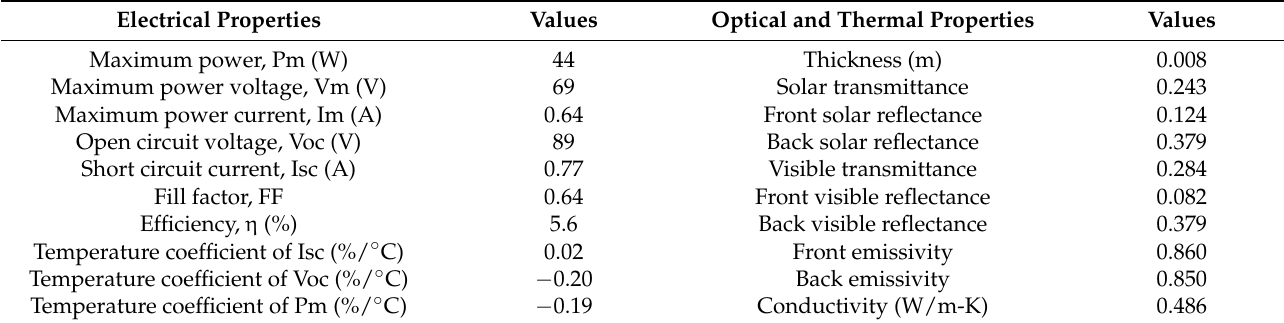
Table 2. Properties of the STPV module.